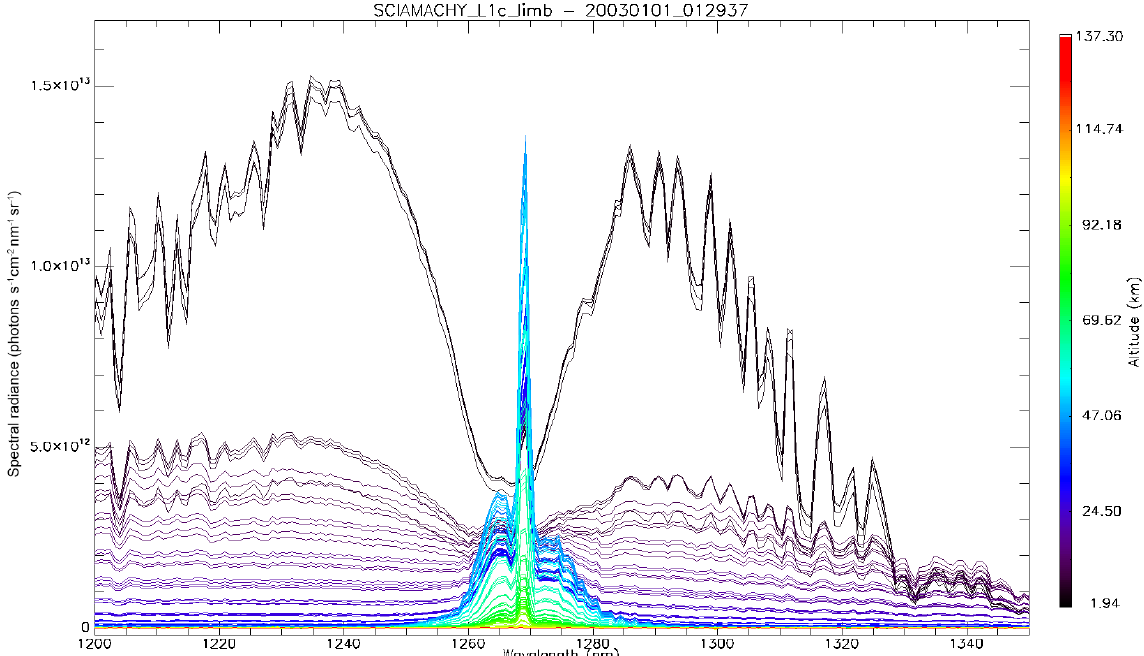
Figure F3. Same as Fig. F2, after correction of the two bad pixels. In addition to the O 2 ∗ airglow, there is the radiance of solar light scattered by air and aerosols, increasing when tangent altitude is decreasing. The strong absorption of O 2 in the 1.27µm band becomes obvious at the lowest